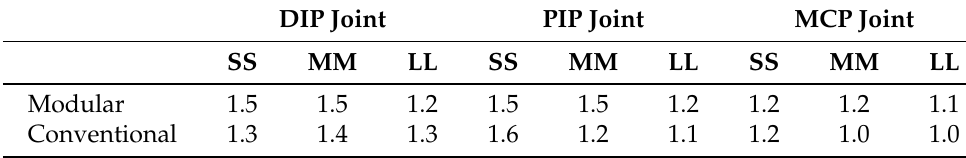
Figure 11. Maximal joint ROMs at 200 kPa for different size dummy finger. ( a ) Modular type; ( b ) conventional type. Table 2. R ROM (the ratio of the ROMs of matched pair and mismatched